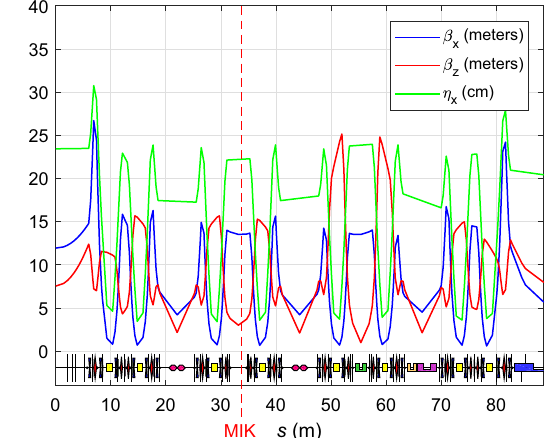
FIG. 1. Twiss functions of a quarter of the SOLEIL storage ring. Horizontal and vertical betatron functions ( β x , β z ) are plotted in blue and red solid lines, respectively, while the horizontal dispersion η x corresponds to the green solid line. The electromagnetic elements of the lattice are drawn at the bottom of the figure: dipoles (yellow), focusing and defocusing quadrupoles (blue and red), sextupoles (pink and green), and rf cavities are in the first to medium straight sections around s ¼ 20 and 40 m (pink) while remaining short and medium straight sections are filled with insertion devices. The black dots and vertical bars symbolize BPMs and correctors,